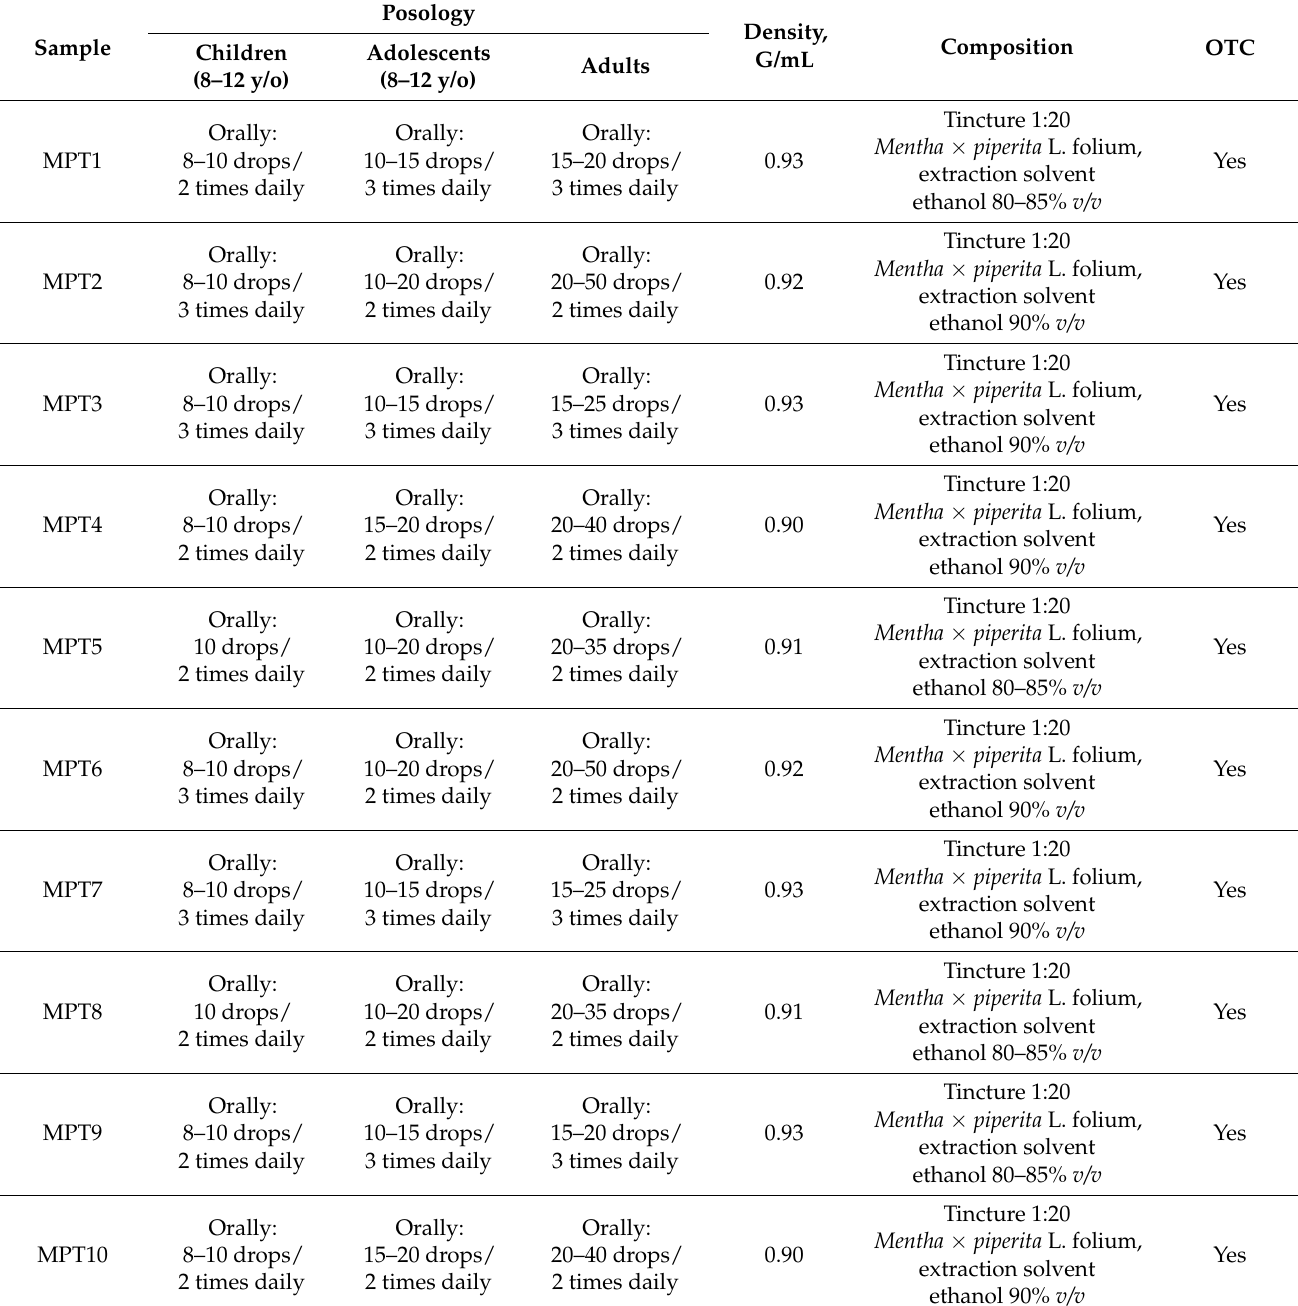
Table 1. The summary of all analyzed HMP with Mentha × piperita L.,